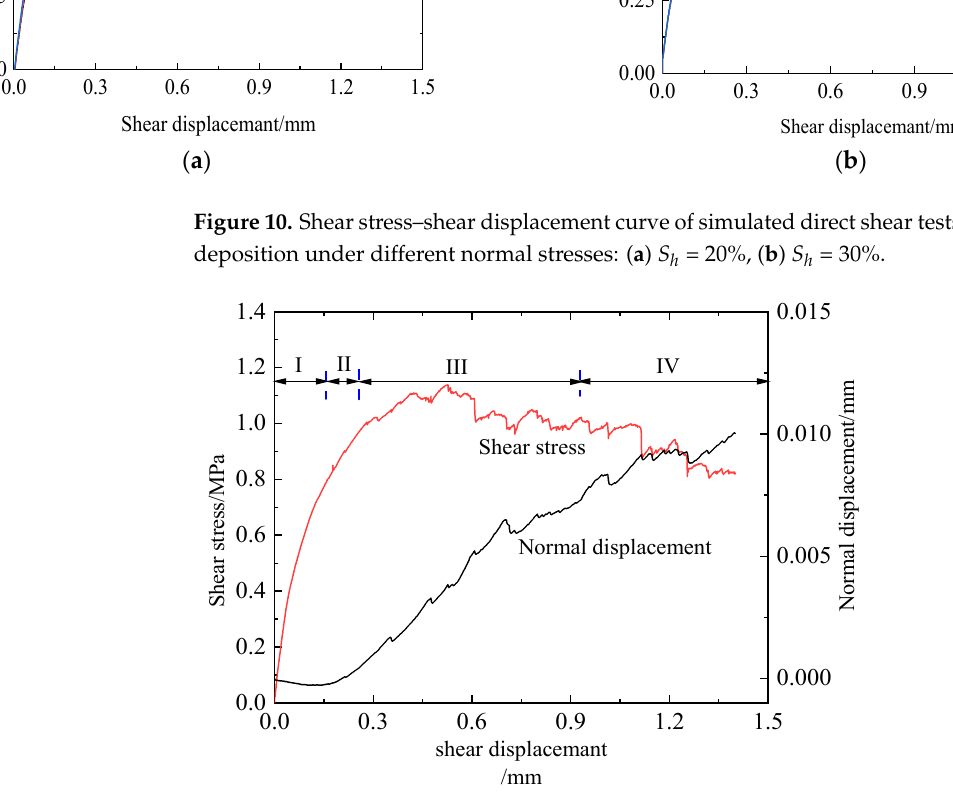
Figure 11. The relationship between the peak strength of nature gas hydrate deposition, E 50, and the loading amplitude.